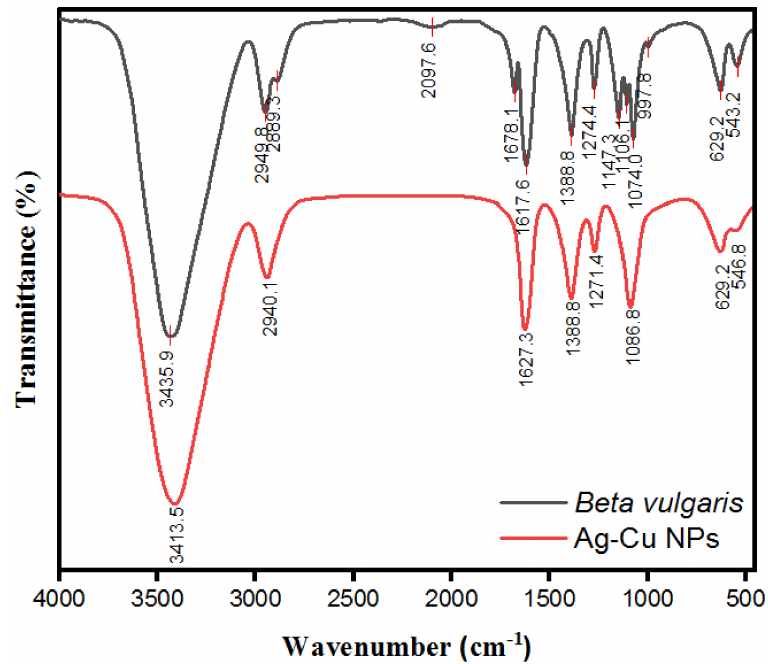
Figure 4. Fourier transforms infrared (FTIR) spectra of Beta vulgaris extract and Ag-Cu bimetal- lic